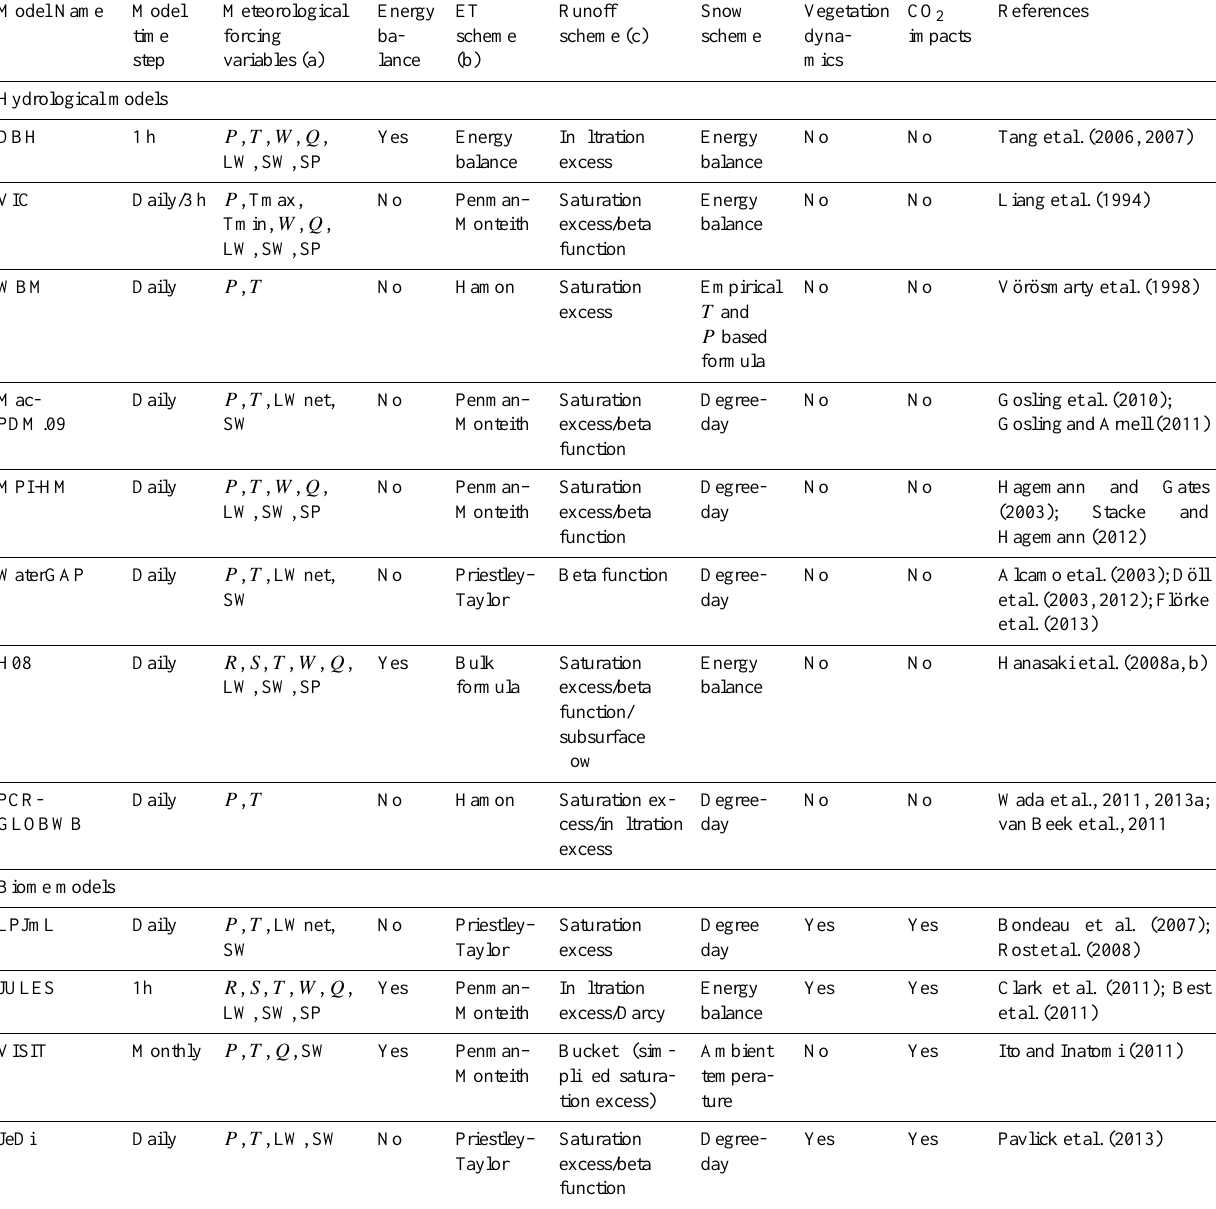
Table 1. Models used in the present study and their main characteristics (in part, after Haddeland et al. (2011)) – (a) R =rainfall rate; S =snowfall rate; P =precipitation (rain or snow distinguished in the model); T =air temperature; Tmax=maximum daily air temperature; Tmin=minimum daily air temperature; W =windspeed; Q =specific humidity; LW=longwave radiation flux